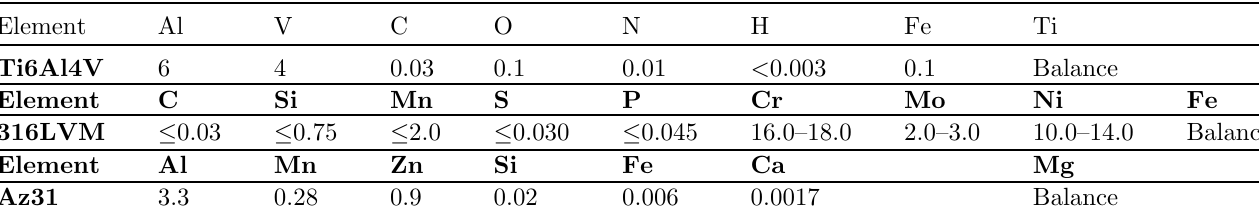
Table 1. Chemical composition of Ti-6Al-4V, 316 LVM and AZ31 (wt%). Element Al